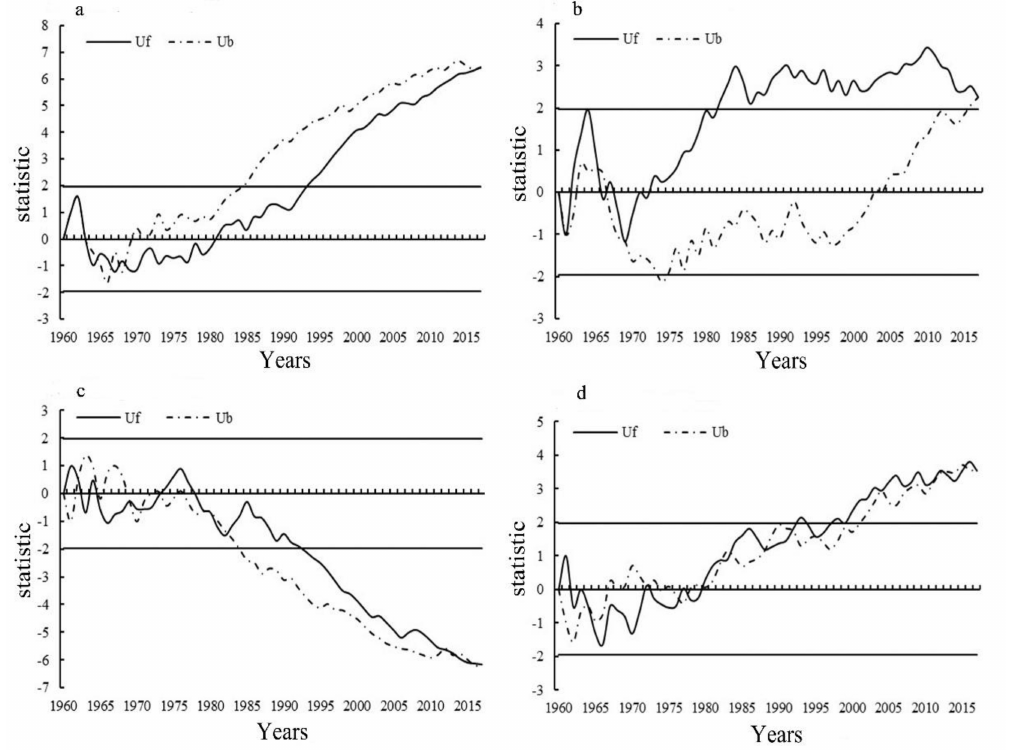
Figure 6. Sub-regions show significant trends in seasonal analysis. The symbol ( a – d ) stands for sub-region 5 of spring, sub-region 4 of summer, sub-region 6 of fall, and sub-region 7 of winter, respectively. Uf is a sequence of statistics calculated in chronological sequence. Ub is a sequence of statistics calculated in reverse chronological sequence. If the value of Uf or Ub is greater than 0, it indicates an upward trend while is shows a downward trend when the value is less than 0. When they pass a critical line, it indicates a significant upward or downward